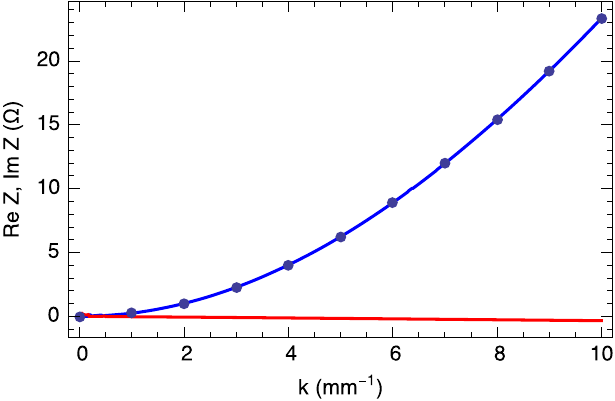
FIG. 5. Comparison of the analytical theory (dots) and numeri- cal simulations (solid lines) for the case of a kink orbit. The blue line shows the real part and the red line shows the imaginary part of Z computed by the code. The dots show Re Z computed using Eq. (54) (the imaginary part is equal to zero and is not